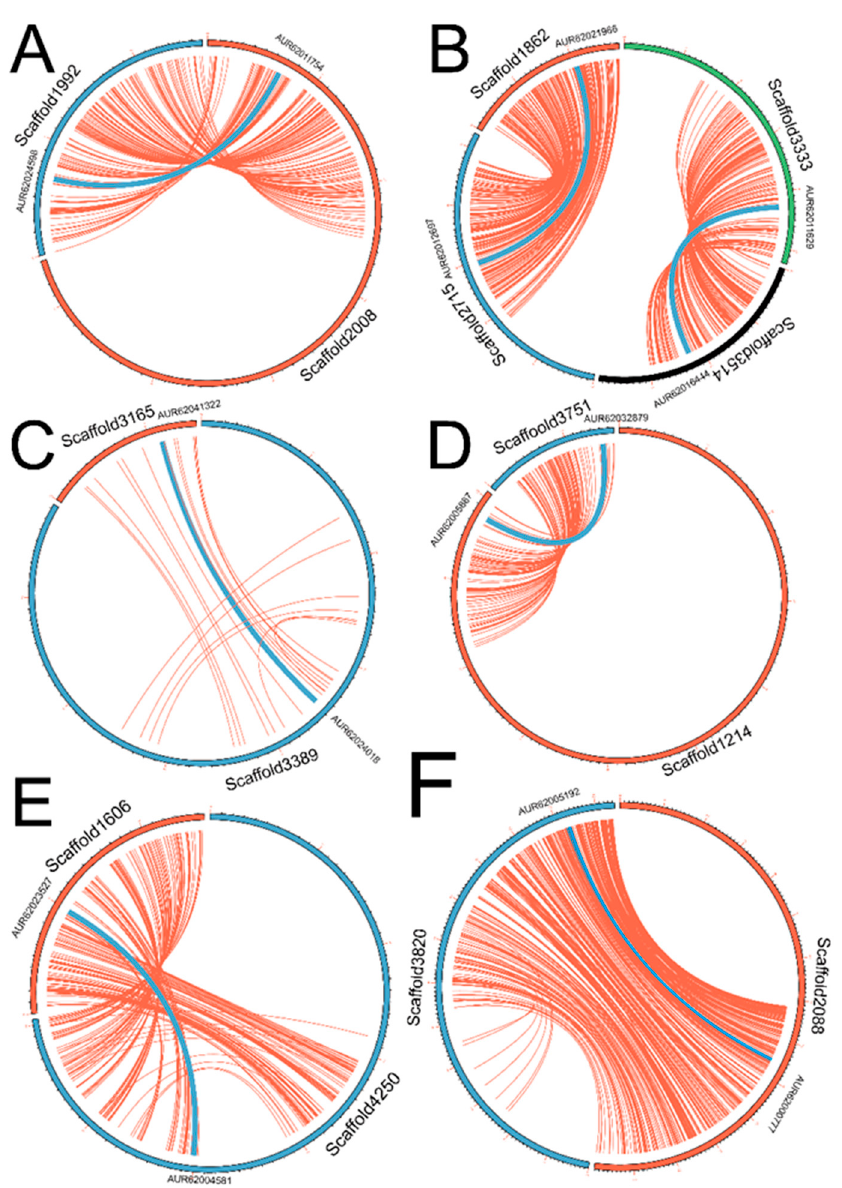
Figure 5. Synteny analysis of Cqhsp 70. The synteny and collinearity regions of the Cqhsp 70 paralogous pairs in their scaffold were performed with MCScanX [29]. Seven out of the eight pairs were used except the AUR62040144–AUR620440617 pairs whose scaffolds are too short to investigate the synteny region. The Cqhsp 70 paralogous pairs were indicated by the blue lines while the red lines represented the conserved region in scaffolds. Note: ( A )–( F ) in this figure are consistent with the clade source of those paralogous pairs in Figure 2.